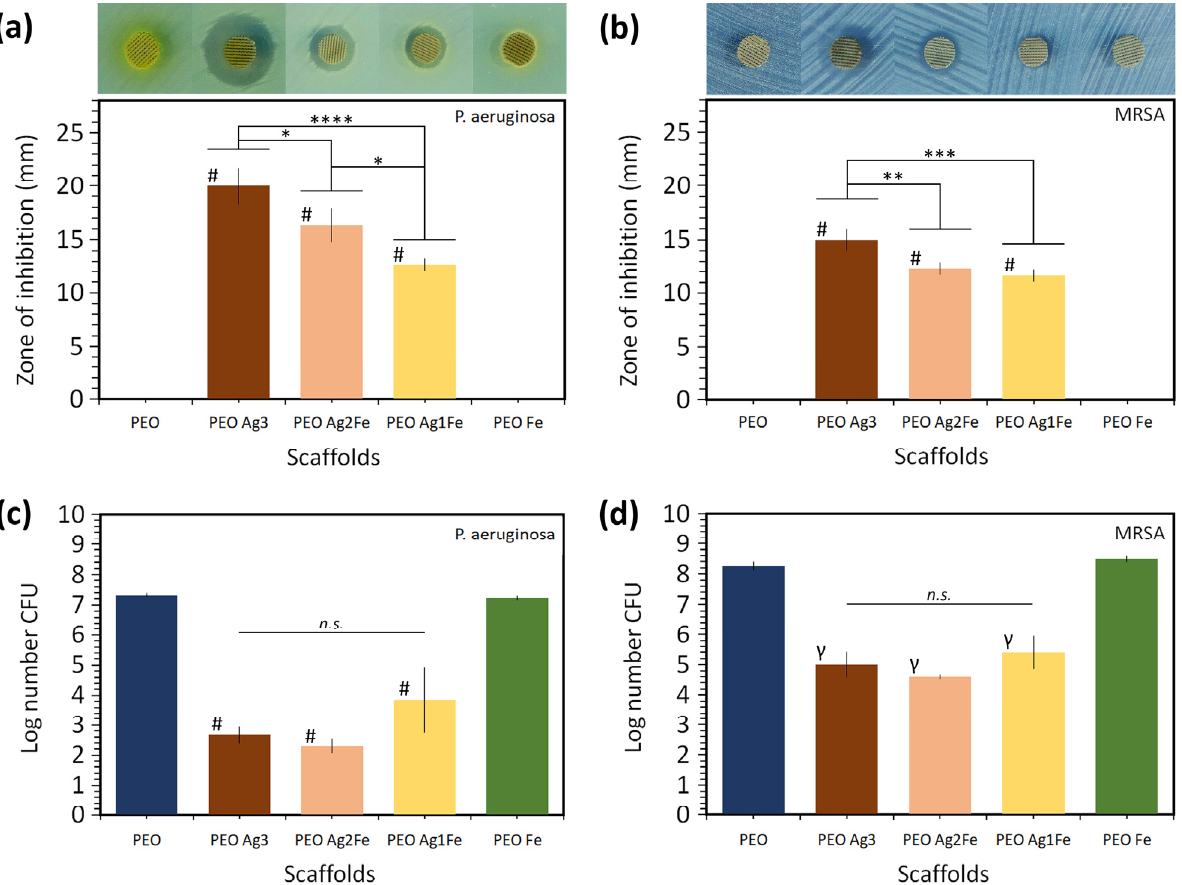
Figure 4. The zones of inhibition around the biofunctionalized scaffolds after 24 h of incubation on agar plates swabbed with a 10 7 CFU/mL of ( a ) P. aeruginosa and ( b ) MRSA. The quantitative bactericidal activity of the scaffolds against ( c ) 2.6 × 10 6 CFU of P. aeruginosa after 1 h of incubation and ( d ) 1.3 × 10 9 CFU of MRSA after 4 h of incubation. **** = p < 0.0001, *** = p < 0.001, ** = p < 0.01, * = p < 0.05, # = **** vs. PEO and PEO Fe groups, γ = ** vs. PEO group and **** vs. PEO Fe group, n.s. = not significant.